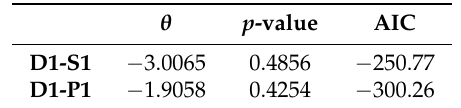
Table 4. Parameters of the Frank Copula Function and the fitting test results.